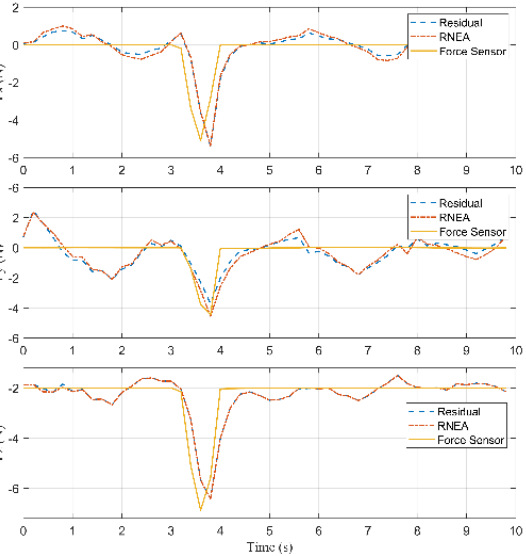
Figure 13. Residuals, the computed forces by RNEA and the force sensor in Case 1.